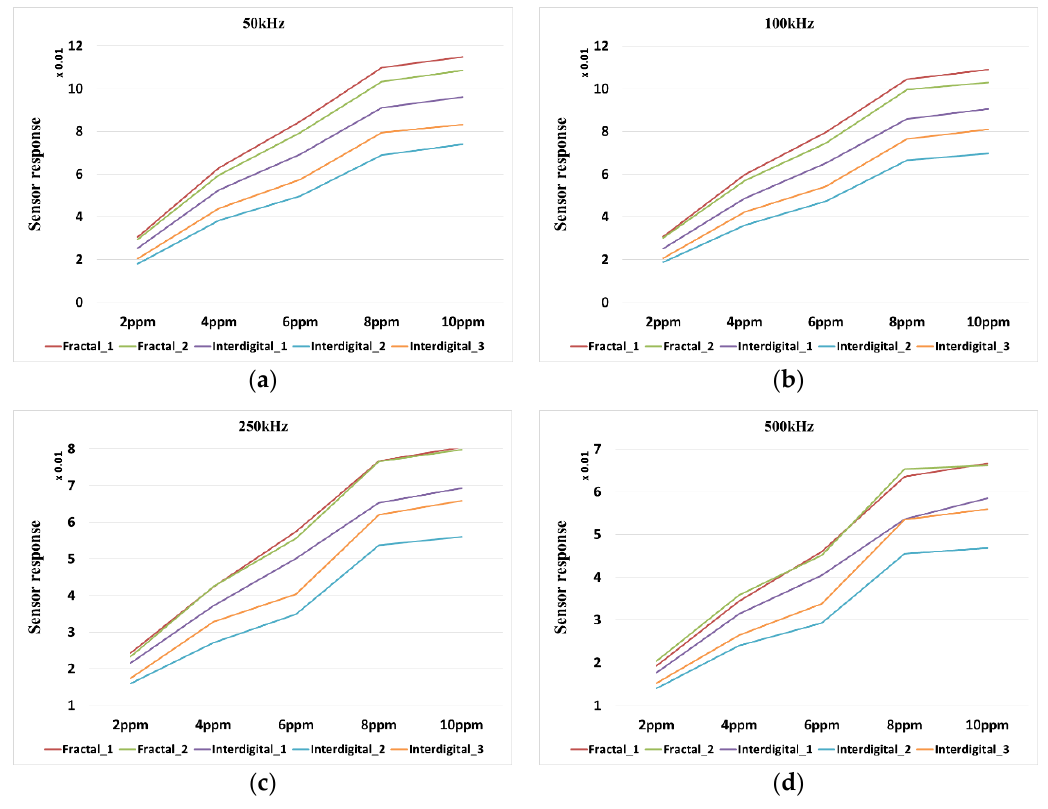
Figure 12. Comparison of sensor responses between the two structures. ( a ) Response at 50 kHz; ( b ) response at 100 kHz; ( c ) response at 250 kHz; ( d ) response at 500 kHz.